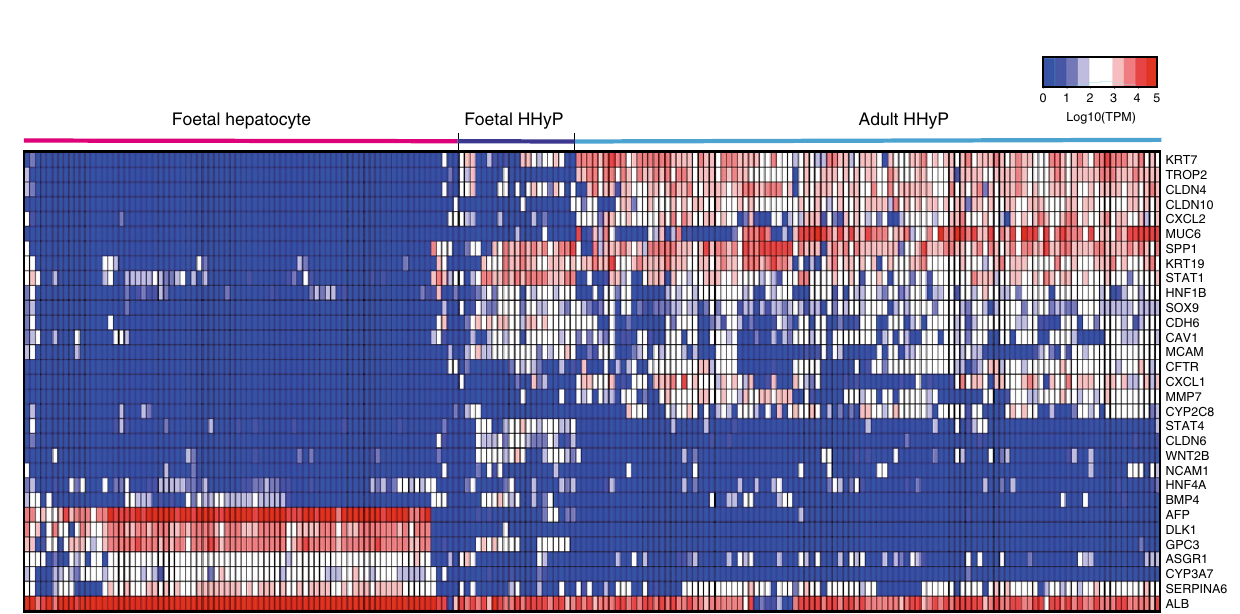
Fig. 2 Comparison of foetal hepatic and HHyP scRNA-seq populations. Heat map of selected gene expression in foetal hepatic, foetal hybrid hepatobiliary progenitor (HHyP) and adult HHyP cells. Gene expression in Log10(TPM). TPM transcripts per